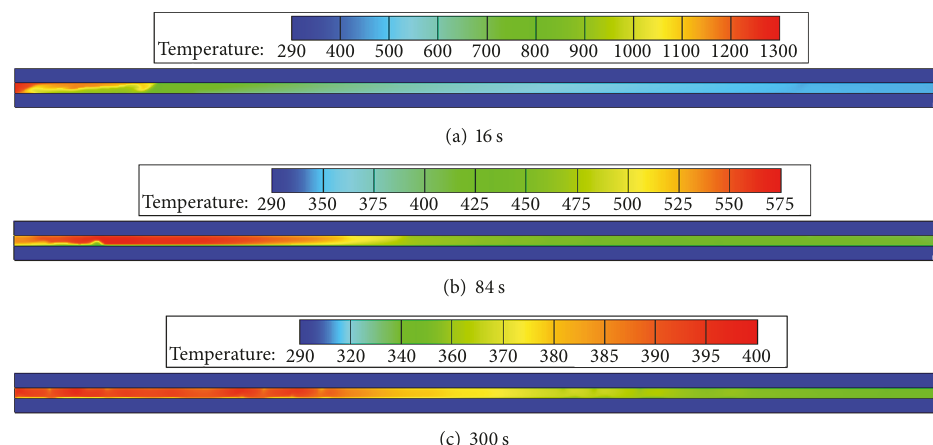
Figure 7: Temporal and spatial variation of temperature in the blocked tunnel.